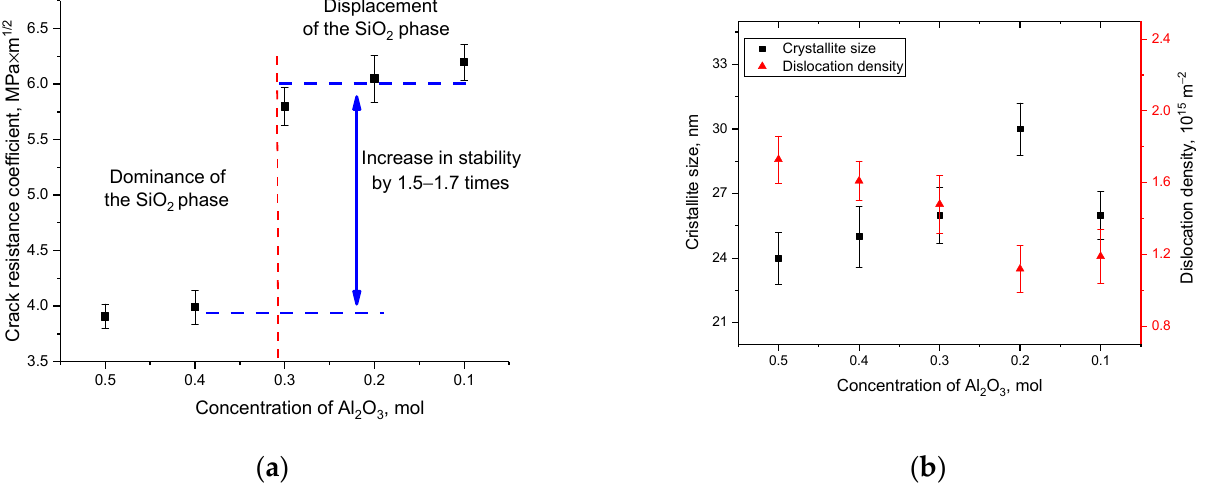
Figure 13. ( a ) Results of evaluation of the change in crack resistance depending on the variation of components in the composition of ceramics; ( b ) Results of the change in crystallite sizes and dislocation density depending on the variation of the components in the composition of ceramics.